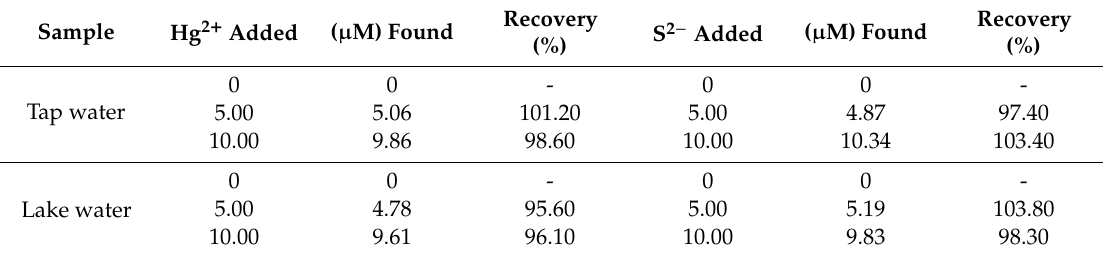
Table 1. Analytical results of Hg 2 + and S 2 − in tap water and lake water samples (n = 3).